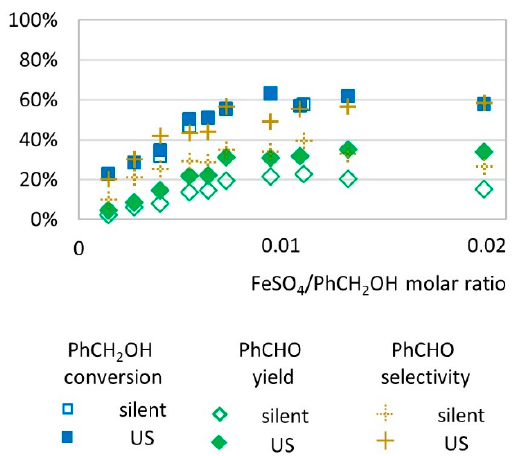
Figure 3. Oxidation of PhCH 2 OH as a function of molar ratio catalyst / substrate in silent condition and under US irradiation (20 kHz). Reaction conditions: 571 mM PhCH 2 OH, 1 molar eq. H 2 O 2 ; 5.61 mL H 2 O, 70 °C, 15 min. Silent conditions: Argon bubbling; US conditions: 20 kHz, P acous = 47.9 W L − 1 h − 1 , 13 mm probe.